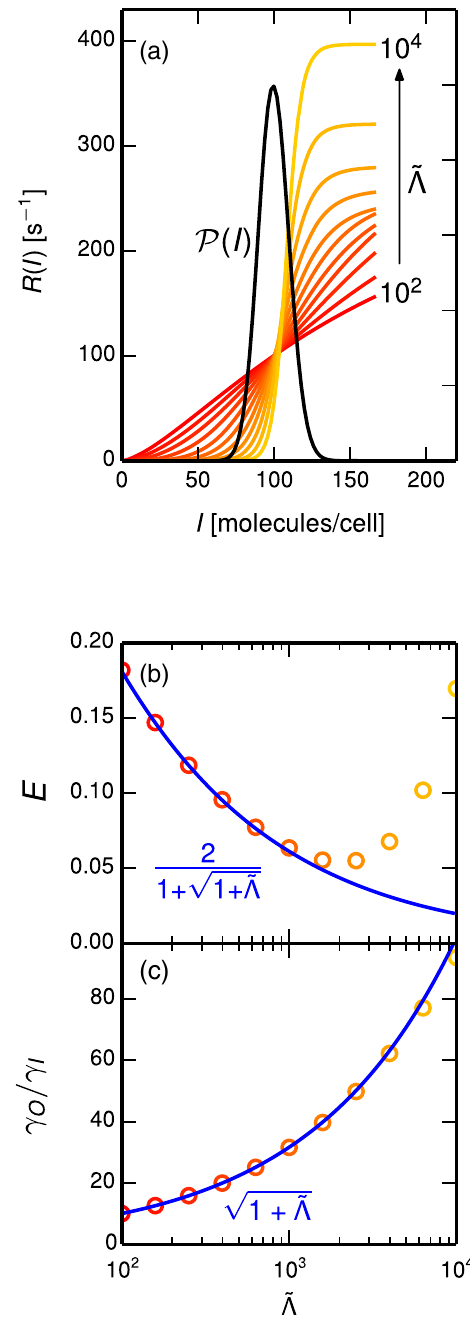
FIG. 2. Optimal noise reduction in the minimal signaling circuit [Fig. 1(c)]. (a) Numerical optimization results for the Hill production function R ð I Þ that minimizes relative error E between input and output, with each color corresponding to ~ Λ different values of the parameter ¼ 10 2 – 10 4 (see text for other parameters). The input probability distribution P ð I Þ is super- imposed in black (the height scale is arbitrary). (b) For each ffiffiffiffiffiffiffiffiffiffiffiffi ~ Λ value of from (a), circles show the minimal E . The lower bound E [Eq. (9)] is drawn as a blue curve. (c) Analogous to (b), opt = γ but showing the ratio γ at which the minimum E is achieved. O I ffiffiffiffiffiffiffiffiffiffiffiffi p The blue curve shows the WK prediction for this ratio, γ 1 þ ~ Λ = γ O I ¼